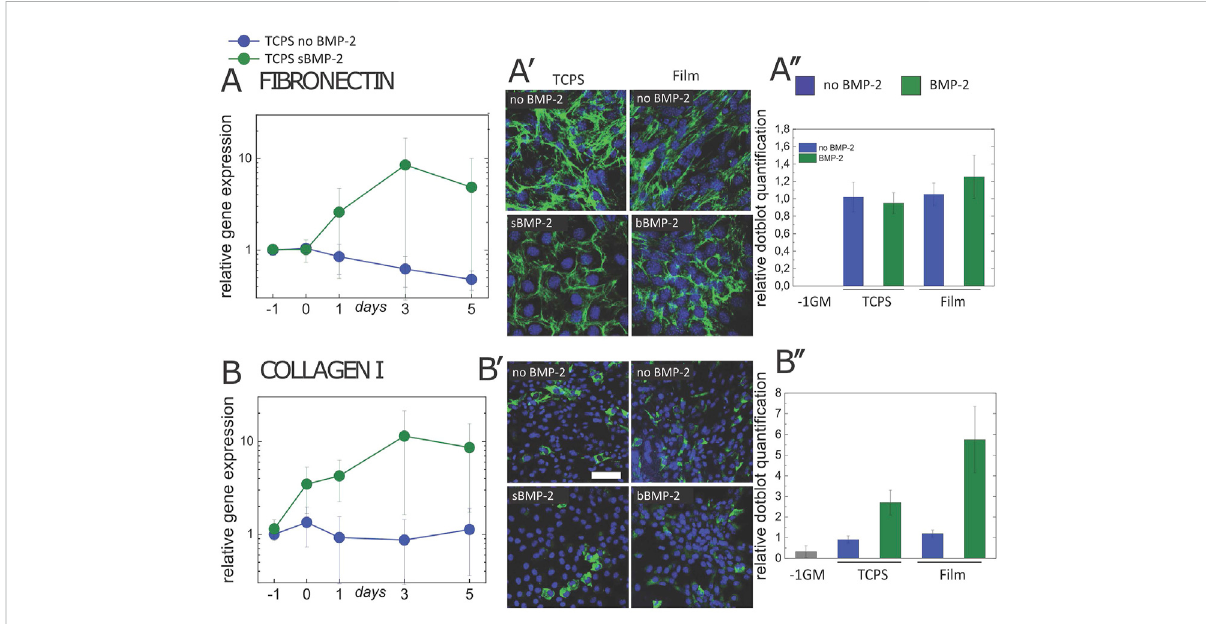
FIGURE 2 bBMP-2 and sBMP-2 induce thegene expression, secretion and remodeling of fi bronectin and collagen I inC2C12 cells. (A,B) Gene expression ofFNandCOLL1werefolloweduptoD5inthepresence(green)orabsence(blue)ofsBMP-2onTCPS.AtD5forcellsgrownon fi lmswithbBMP-2or on TCPS with sBMP-2 (A 9 ) FN and (B 9 ) COLL1 werestained using immuno fl uorescence and quanti fi edby dot blot (A'',B'' respectively ) , by taking actin as a control. Scale bars are 150 µm. Data are mean ± SEM of three independent